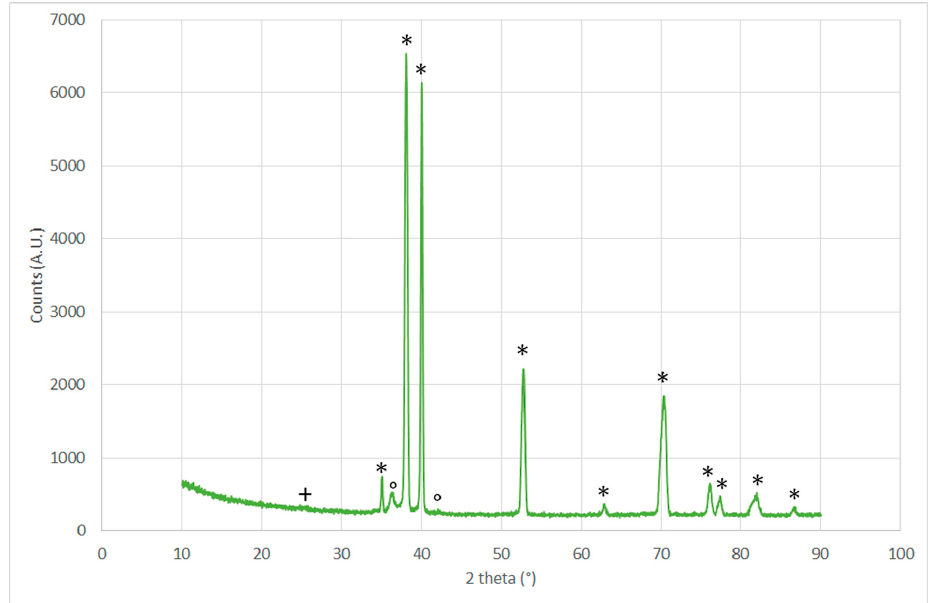
Figure 8. X-ray diffraction pattern indicating the presence of: + TiO 2 [JCPDS 021–1276] rutile, *